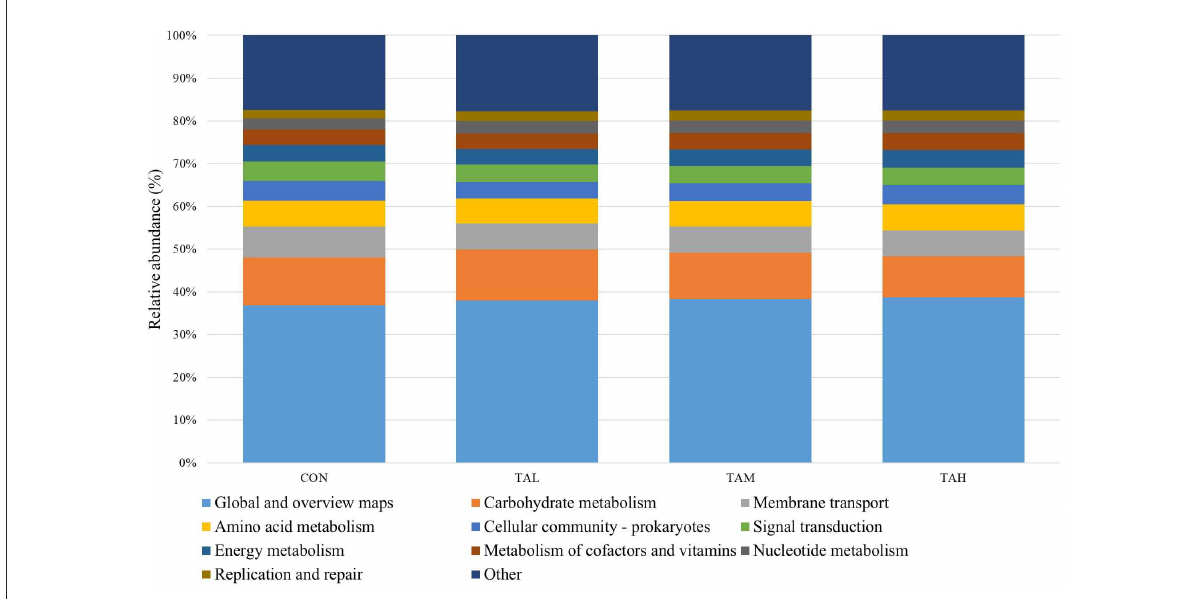
FIGURE3 The top ten annotated KEGG pathways (at level 2) across treatments based on Tax4Fun function